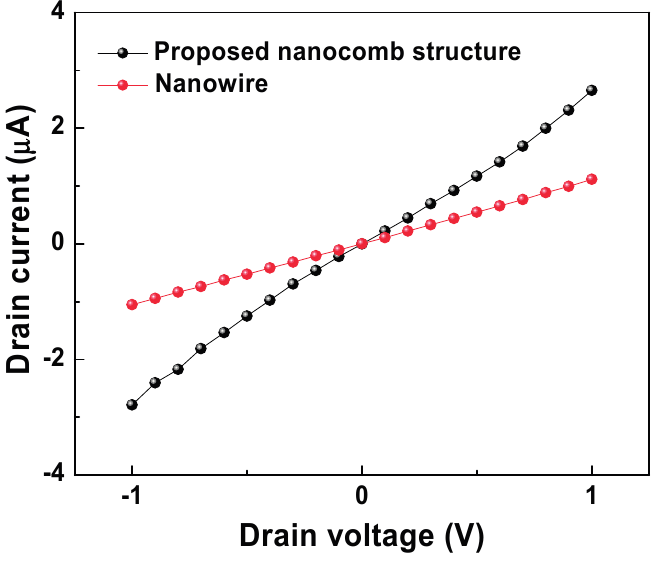
Figure 6. FET drain current comparison between the nanocomb and the